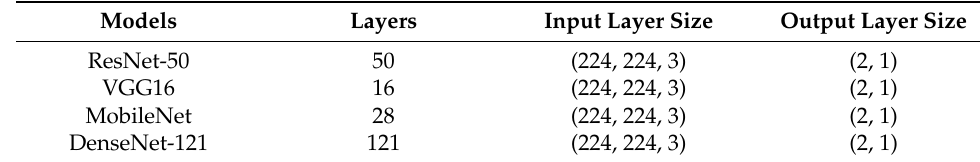
Table 2. Architectural parameters of the four CNN models used in this research.